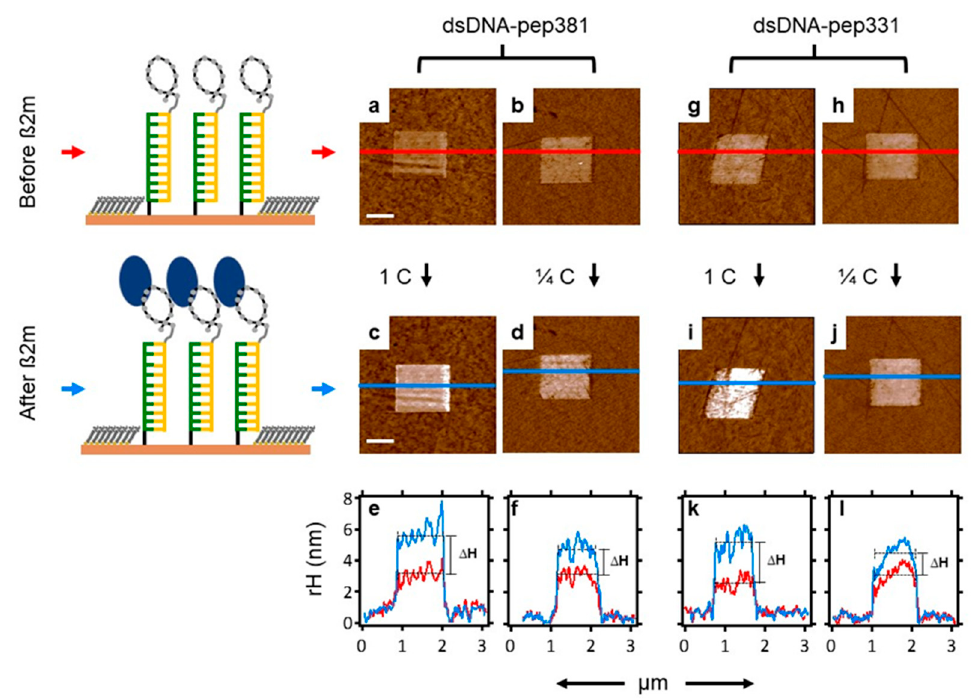
Figure 8. AFM detection and quantification of the recognition of ß2m by dsDNA–peptide at different concentrations of the analyte. From the left-hand side, ( a , b ) show the AFM images of dsDNA–pep381 before treatment with ß2m solution. On the left of ( a ), we have the schematic that depicts the laterally confined dsDNA–peptide molecules surrounded with the bioresistant TOEG monolayer. ( c , d ) show the same AFM images in ( a , b ) after treatment with 1C (5 mg/mL) and ¼ C (1.25 mg/mL) solution of ß2m. On the left of ( c ), we have a representation of binding of ß2m by the laterally confined dsDNA–peptide molecules. ( e , f ) represent plots of relative height profiles corresponding to the lines across (( a , b ), red) and (( c , d ), blue), respectively. ( g , h ) show the AFM images of dsDNA–pep331 before treatment with ß2m solution. ( i , j ) show the same AFM images in ( g , h ) after treatment with 1C (5 mg/mL) and 1 C (1.25 mg/mL) solution of ß2m. ( k , l ) represent graphs 4 of the height profiles corresponding to the lines across (( g , h ), red) and (( i , j ), blue), respectively. ∆ H is the differential height. Each ∆ H was calculated by subtracting the average relative height of the red trace from the average relative height of the blue trace. The thin black dashed lines indicate the averages across the profiles. The scale bar is 600 nm and is applicable for all the AFM